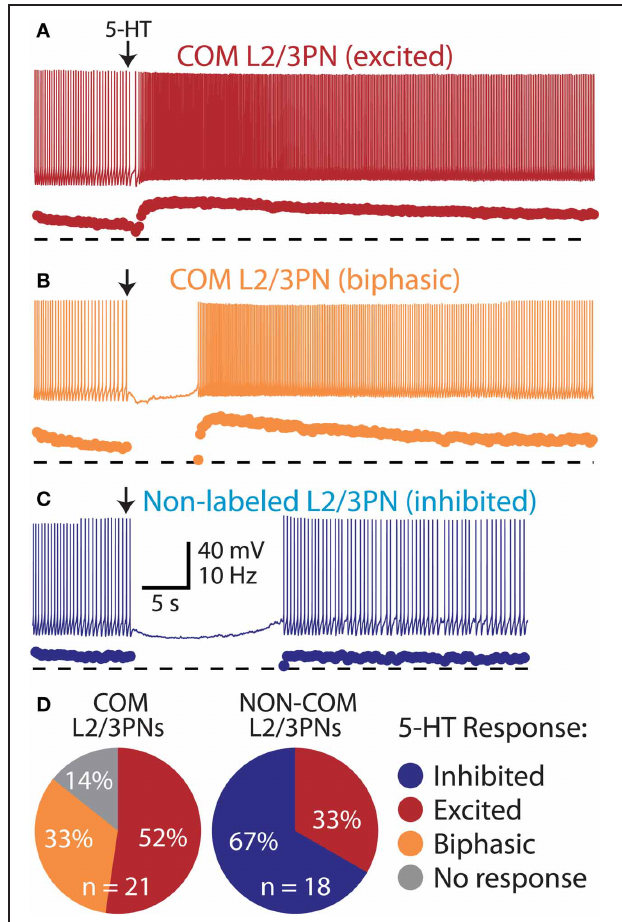
FIGURE 7 | Selective excitation of pyramidal neurons in layers 2/3 of the mPFC. (A) Excitatory response to 5-HT in a COM-labeled L2/3PN (voltage trace, above, and instantaneous spike frequency [ISF] plot, below). Dashed lines indicate zero Hz. (B) Serotonergic response in a “biphasic” COM L2/3PN. (C) Serotonergic inhibition of a non-labeled L2/3PN in tissue labeled for COM neurons. (D) Proportions of serotonergic responses in COM-labeled and neighboring non-labeled L2/3PNs.